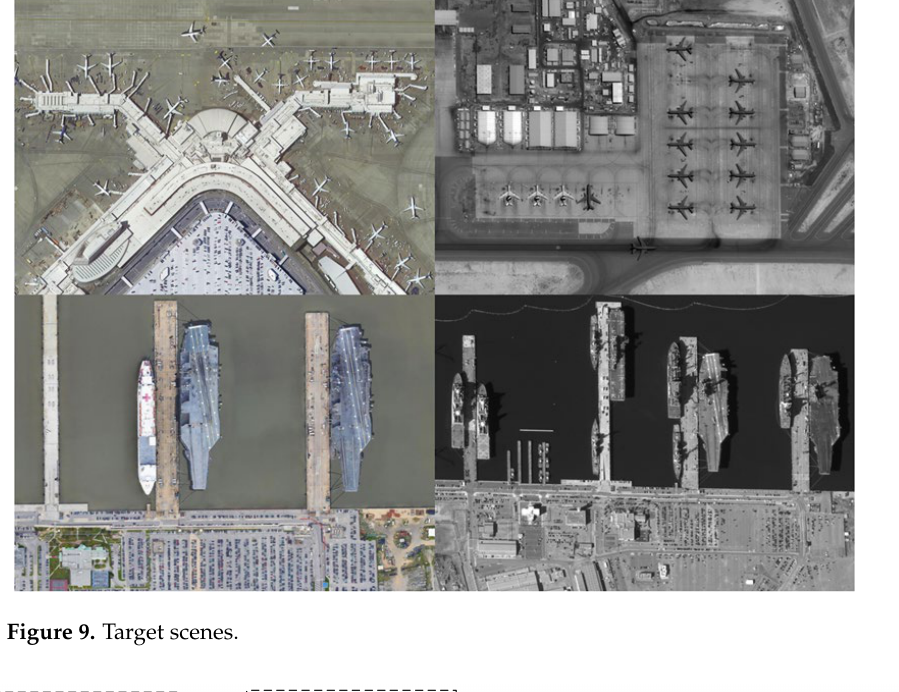
Figure 9. Target scenes.